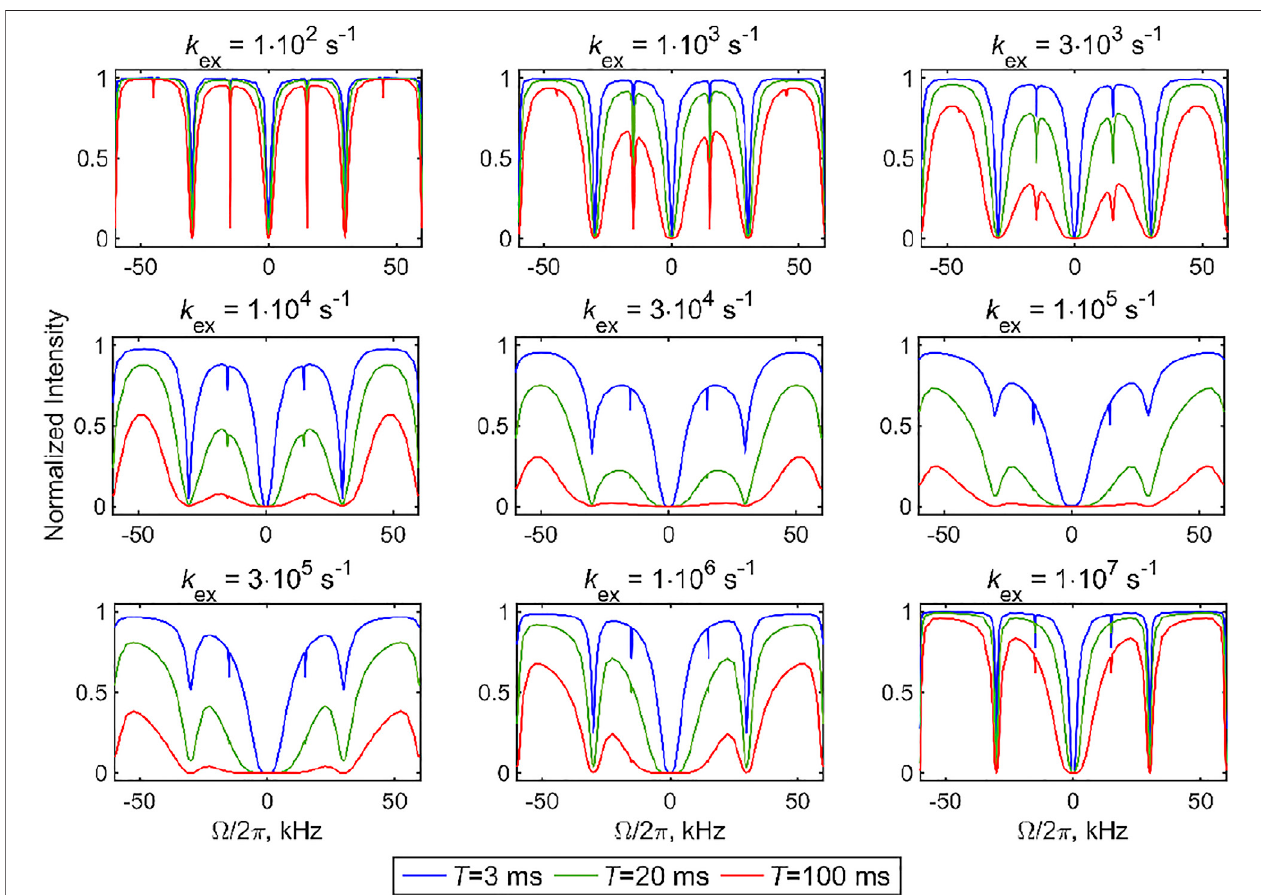
FIGURE 6 | Simulated 2 H CEST pro fi les for the 2-site exchange model using two axially symmetric tensors with the quadrupolar coupling constants of C q (cid:2) 55.3 kHzinbothsites,equalpopulations,ajumpangleof106 ° ,andvaluesofthe k ex rateconstantbetween1 · 10 2 and1 · 10 7 s − 1 .Theintegratedintensityofallthespectral side bands normalized to intensity at T (cid:2) 0 versus offsets Ω / 2 π . The simulations were performed with ω MAS / 2 π (cid:2) 30 kHz, ω RF / 2 π (cid:2) 1.3 kHz, 3000 powder crystallite orientations, and three saturation times T . The offset sampling schedule was 2.5 kHz outside the rotary resonances and 250 – 500 Hz in the vicinity of the rotary